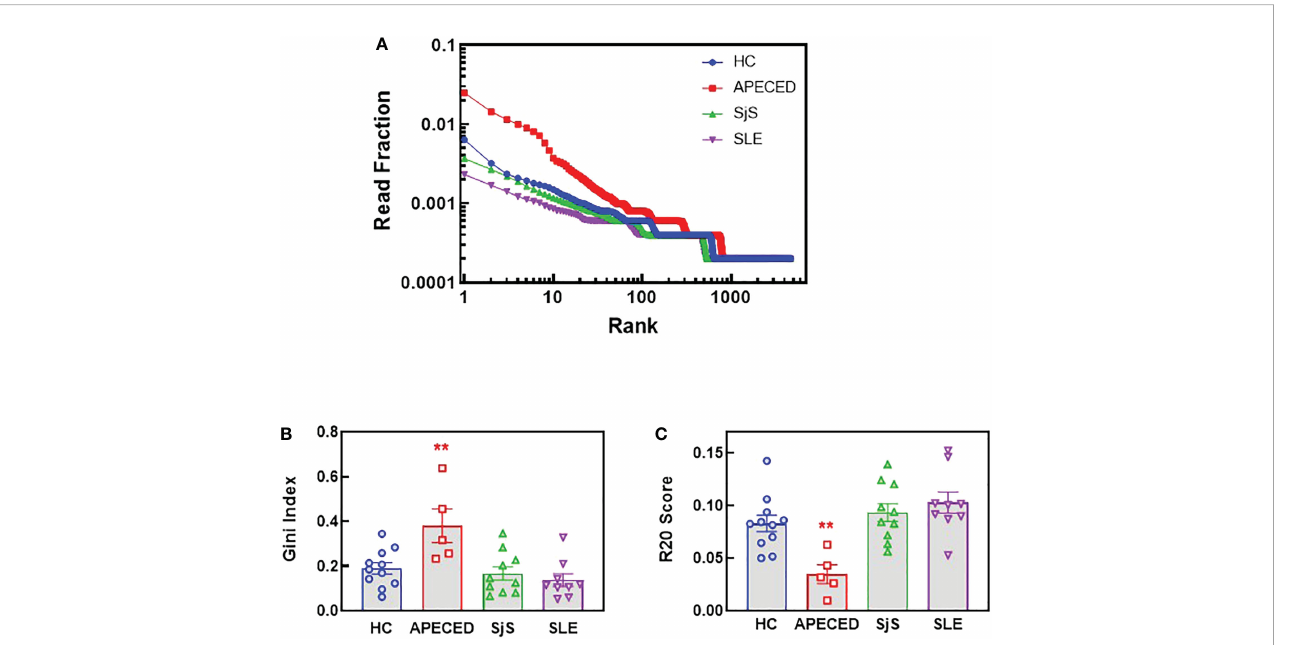
FIGURE 7 NGS BCR repertoire analysis of the sequence diversity and clonality of different disease groups. Switched memory B-cells were isolated from peripheral blood and RNA was puri fi ed for BCR sequencing. (A) The fraction of all reads for each clonotype were plotted with the clonotypes ranked from most abundant to least abundant for the top 4000 clonotypes. (B) The Gini score was calculated based on the clonotype frequency for each patient and the results are plotted by groups. (C) Clonality was determined for each subject and the R20 values for each subject are presented by group as the fraction of unique clones representing 20% of the sequenced repertoire, so the higher the R20 the less clonal dominance. (**signi fi cantly different from HC ANOVA p<0.01). APECED, autoimmune polyendocrinopathy – candidiasis – ecto-dermal dystrophy; BCR, B-cell receptor; HC, healthy control; NGS, next- generation sequencing; SLE, systemic lupus erythematosus; SjS, Sjogren ’ s